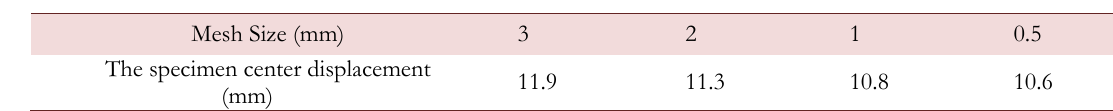
Table 8: Non-dependence on core sample mesh.